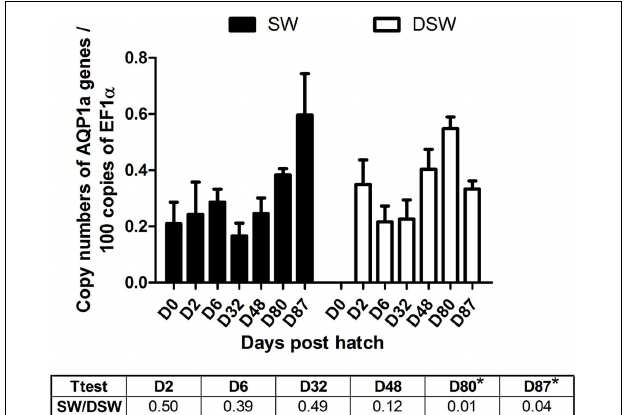
FIGURE 1 | Dicentrarchus labrax. AQP1a transcript abundance evaluated by quantitative PCR, during sea-bass ontogeny, following a 48-h acclimation period in SW and DSW, only D87 was acclimated for 10days. D0 larvae (hatching time) were only exposed to SW. Each value is the mean ± standard error of larvae pools from three samples (D0, D2, and D6, with 30, 10, and 10 fish respectively) or post-larvae pools (D32 and D48, with five fish in each pool) or juvenile individual animals (D80 and D87, six individual fish for each stage). Asterisk (*) indicates differences between SW and DSW samples ( p < 0.05). D, days post-hatch. SW, sea water (1029mOsm · kg − 1 ∼ 35ppt); DSW, diluted sea water (147mOsm · kg -1 ∼